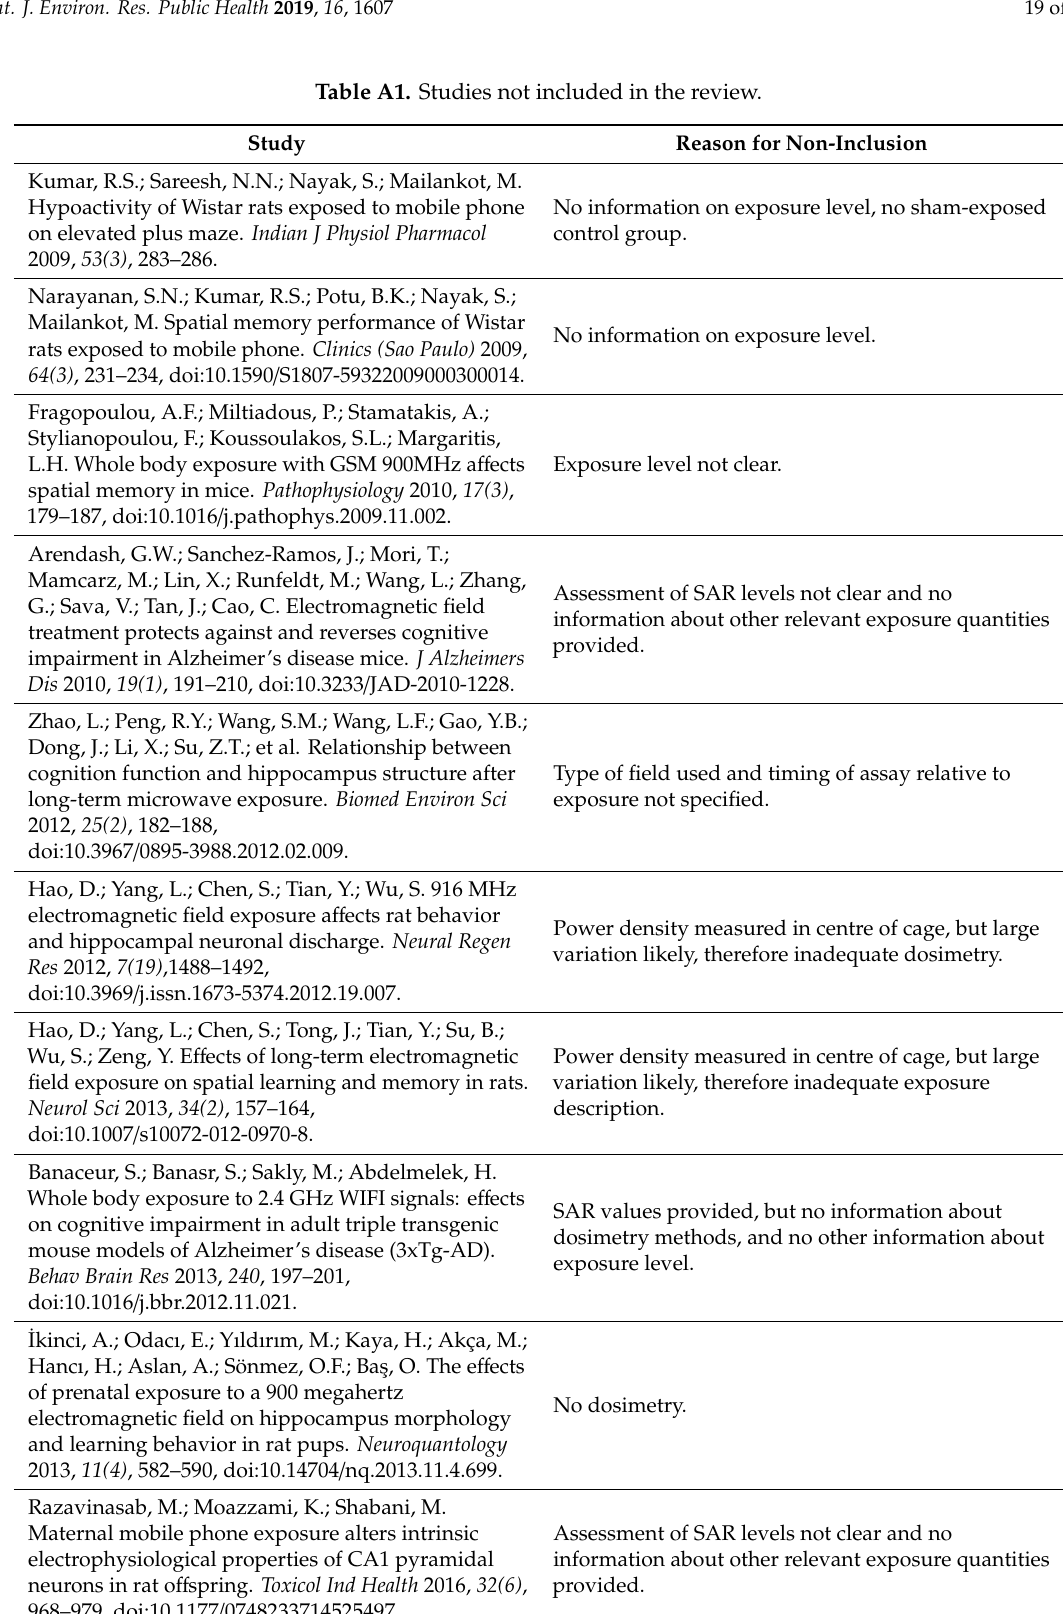
Table A1. Studies not included in the